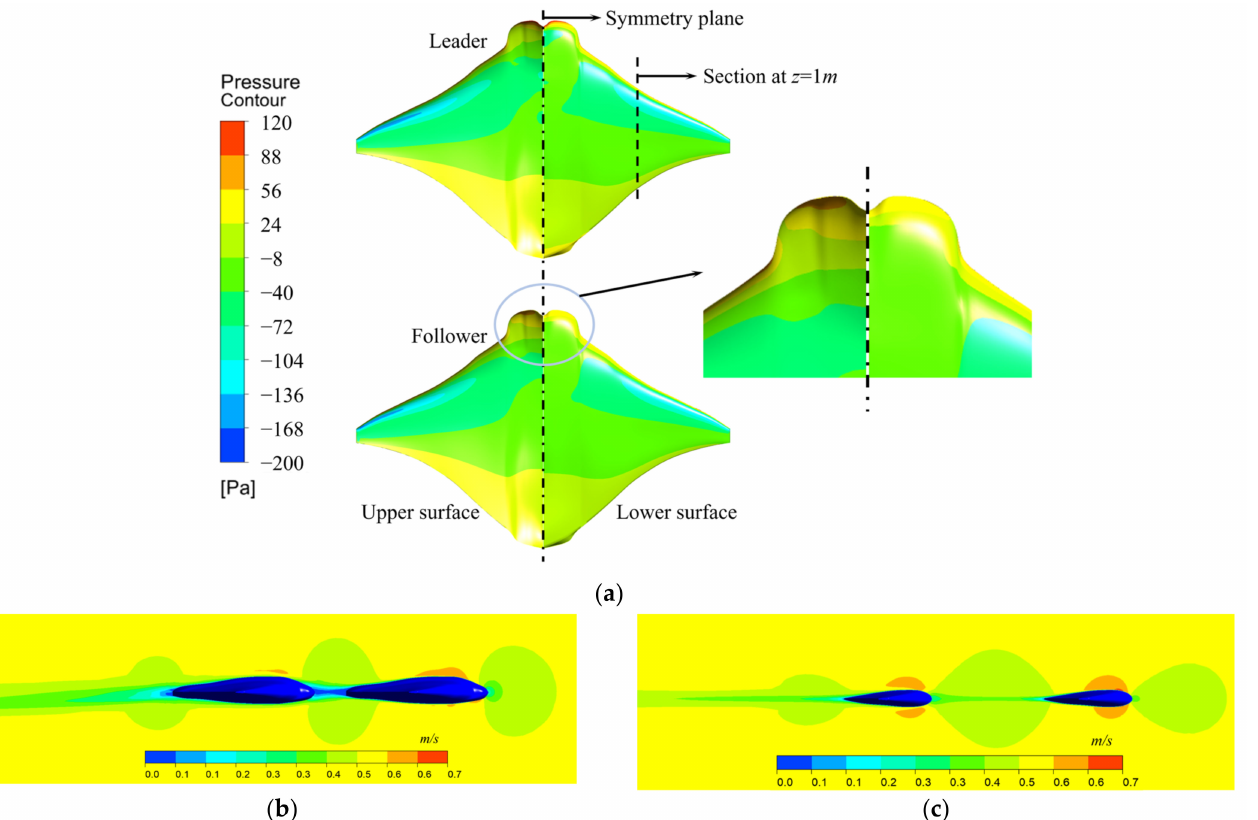
Figure 12. Surface pressure distribution and typical cross-sectional velocity distribution of two manta rays tandem system at α = − 2 ◦ , ∆ s = 0.25 BL. ( a ): Surface pressure distribution. ( b ): Velocity distribution of symmetry plane. ( c ): Velocity distribution of section at z = 1 m.